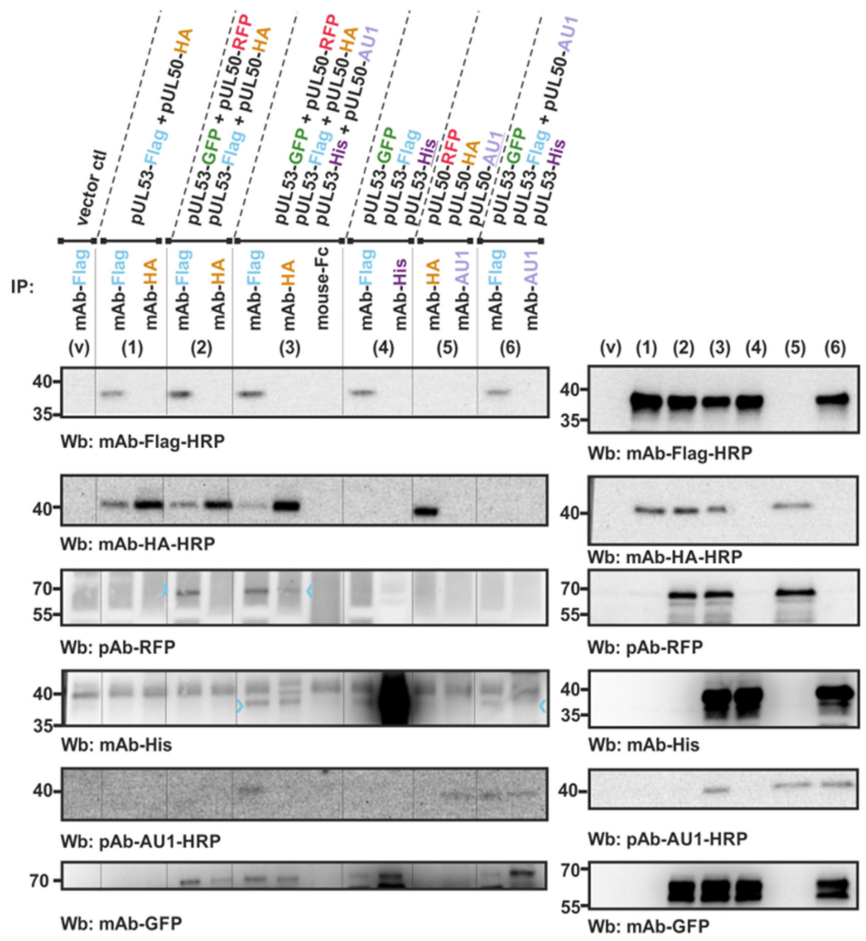
Figure 2. In vitro NEC assembly assay demonstrating the basic potential of oligomeric interaction of the HCMV core NEC proteins pUL50 (groove) and pUL53 (hook). The indicated expression plasmids, as described by Figure 1B, were used for the single transient transfection of 293T cells and harvested at approx. 2 days post-transfection (d p.t.) for the preparation of total lysates. Expression levels of the individual proteins were monitored by the detection of lysate controls on Western blots (right panels: v, vector control; 1–6, single-expression protein samples, subsequently taken as the input